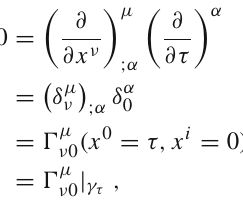
Fermi normal coordinates are parallelly transformed